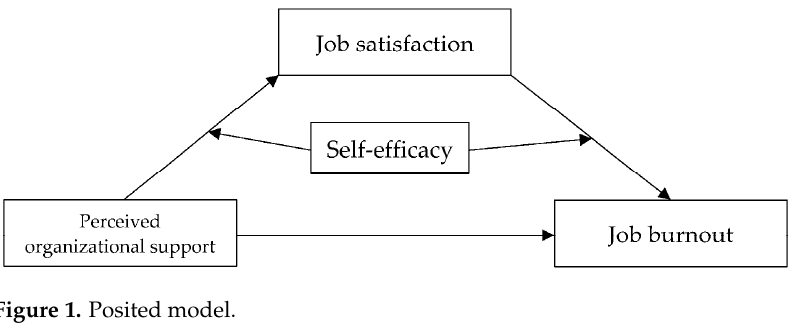
Figure 1. Posited